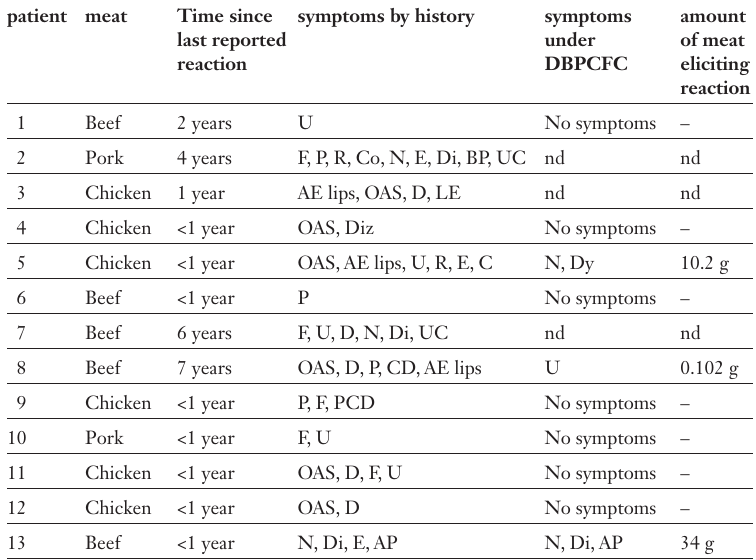
Case histories in respect to meat allergy and results of the DBPCFC with meat.